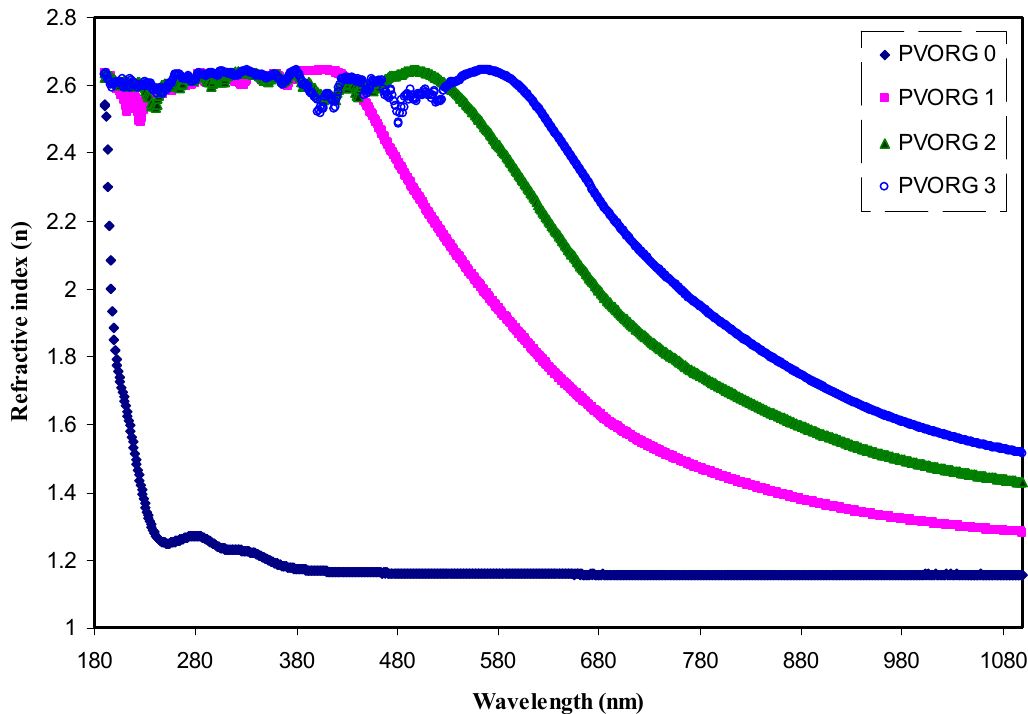
Figure 9. Refractive index spectra versus wavelength for pure PVA (PVORG0) and PVA composite films.